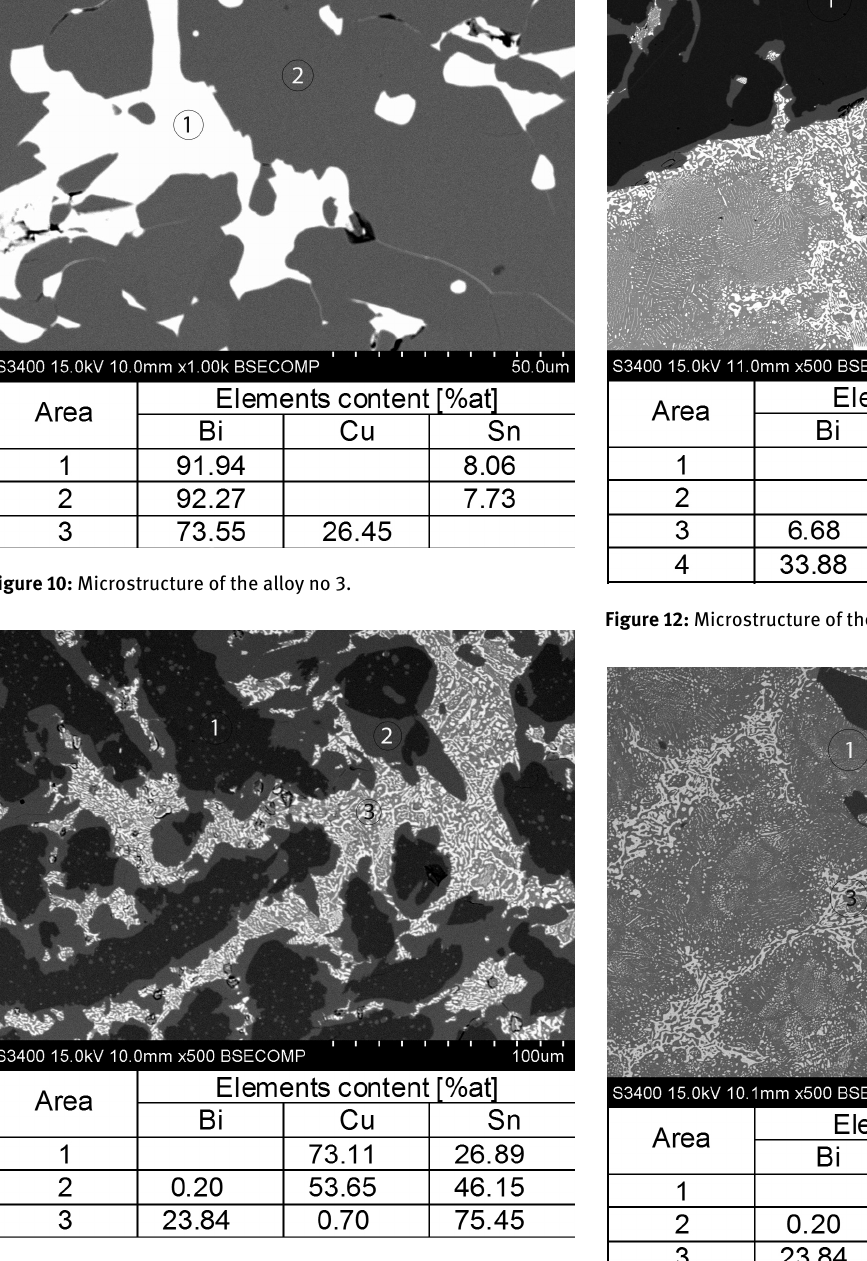
Figure 11: Microstructure of the alloy no 4.